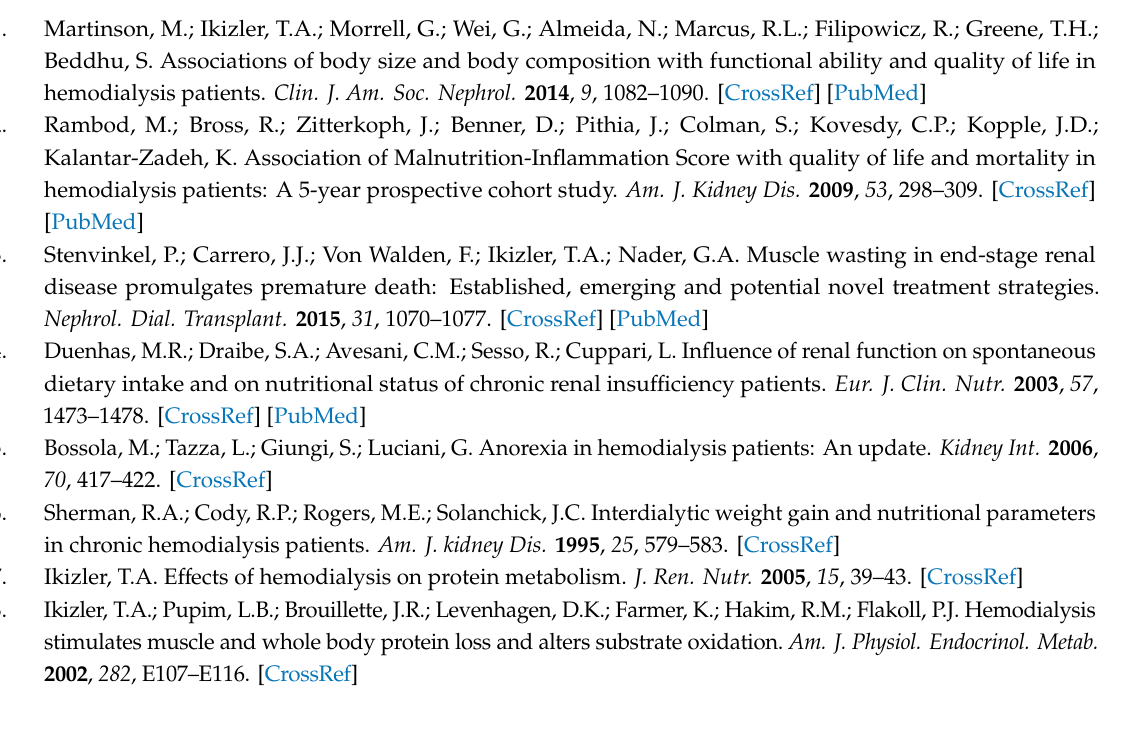
Table S1: Change in primary and secondary study parameters for the patients who completed the 20 week visit ( n =